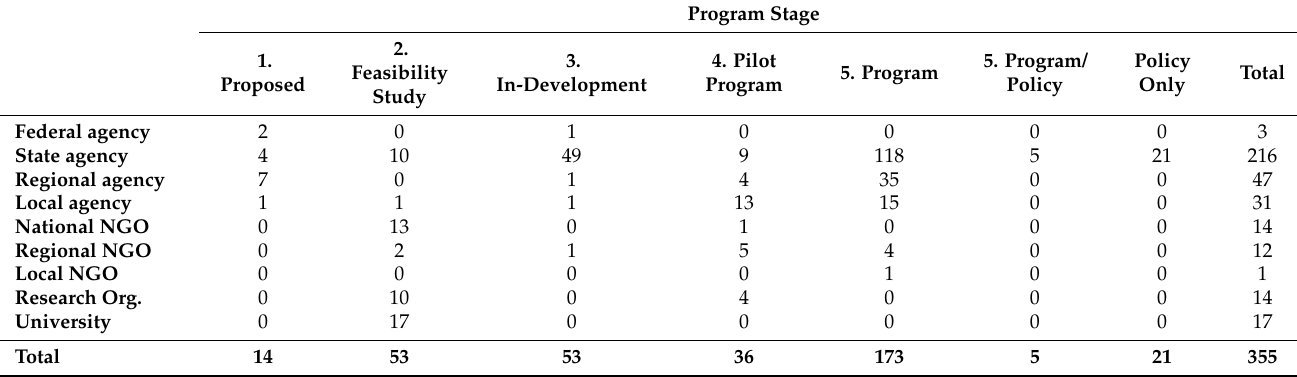
Table A5. Program enabling authorities by program stage (“NGO” is a nongovernmental